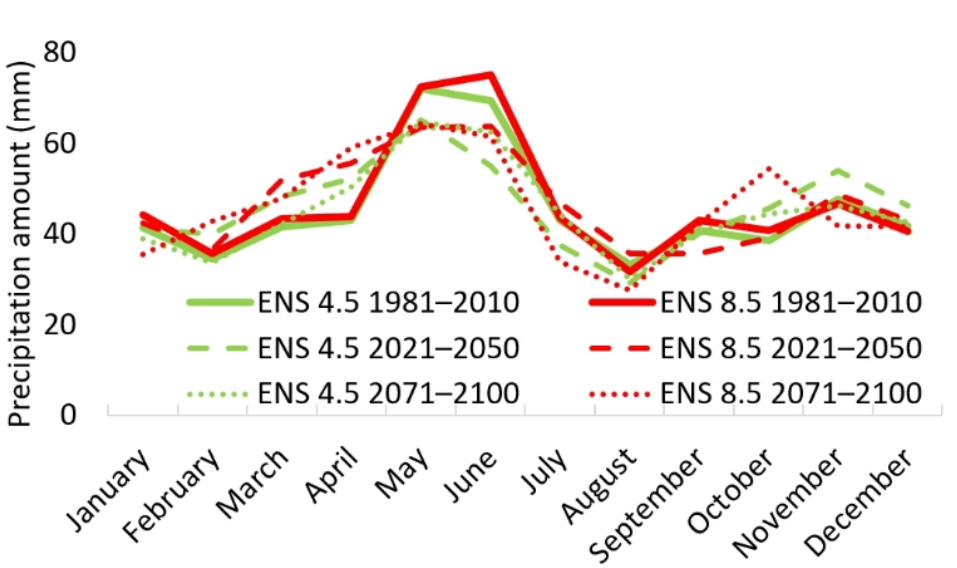
Figure 3. Precipitation amount for the representative monthly year for each climate model output for the reference, short- and long-term period.